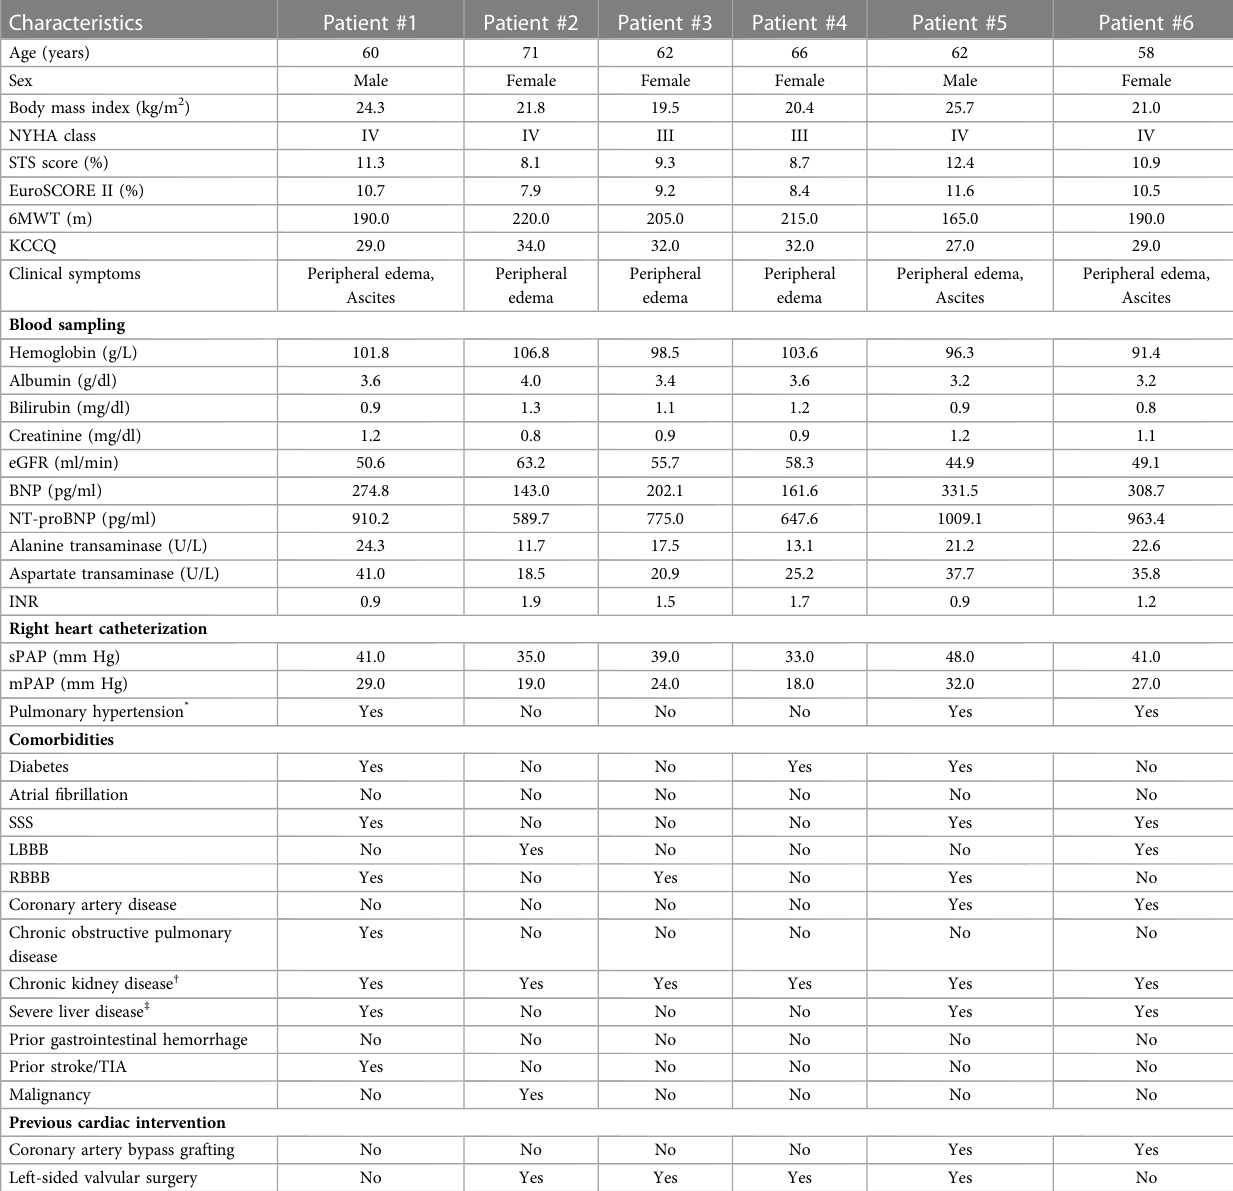
TABLE 1 Baseline patient characteristics.